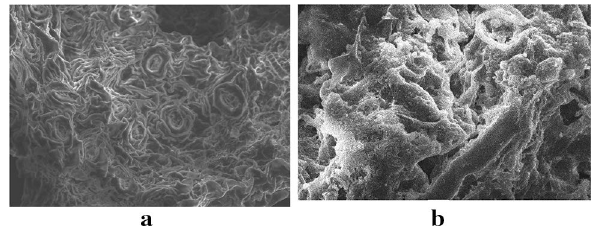
Fig. 7 SEM images of spent tea leaves before ( a ) and after treatment ( b )